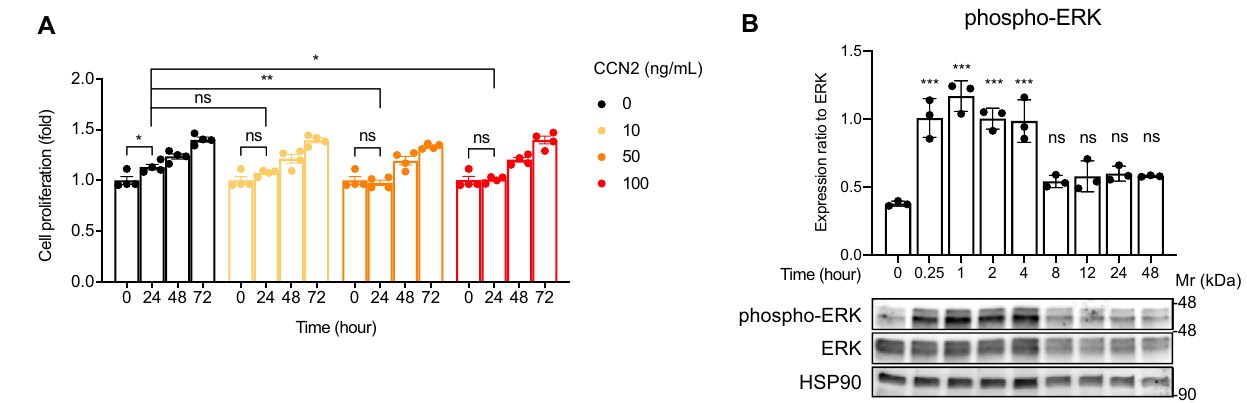
Figure 5. Weak inhibitory effects of CCN2 on the proliferation of LECs and transient phosphorylation of ERK induced by CCN2. ( A ) LECs were cultured in medium containing 0, 10, 50 or 100 ng/mL of CCN2 for 24, 48 or 72 h. Cell proliferation was analyzed by crystal violet staining. Cell proliferation was expressed as the ratio to the value at 0 h. Two-way ANOVA, * p < 0.05, ** p < 0.01. ns; not significant. ( B ) LECs were treated with 100 ng/mL CCN2 for 0, 0.25, 1, 2, 4, 8, 12, 24 or 48 h, and phospho-ERK, ERK and HSP90 were detected by Western blot. Phospho-ERK levels at each time point were normalized to those of total ERK. One-way ANOVA, *** p < 0.001 versus 0 h. ns; not significant versus 0